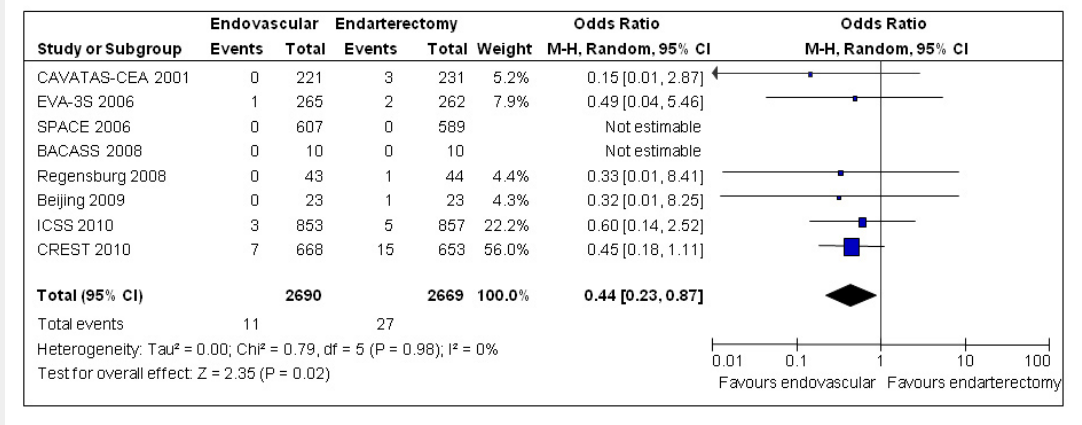
Meta-analysis of randomised trials comparing endovascular treatment with endarterectomy for symptomatic carotid stenosis: myocardial infarction between randomisation and 30 days after treatment. Data are numbers of patients with events, total numbers of patients and Mantel- Haenszel random-effects odds ratios including 95% confidence intervals (CI) for fatal or non-fatal myocardial infarction occurring between randomisation and 30 days after treatment, with endarterectomy as the reference treatment. Squares on the right represent point estimates of odds ratios at trial level, with 95% CI as horizontal bars. The diamond at the bottom represents the summary OR and 95% CI. Data from the following trials are included: CAVATAS [13], EVA-3S [14], SPACE [15], BACASS [50], Regensburg [52], Beijing [51], ICSS [17], CREST